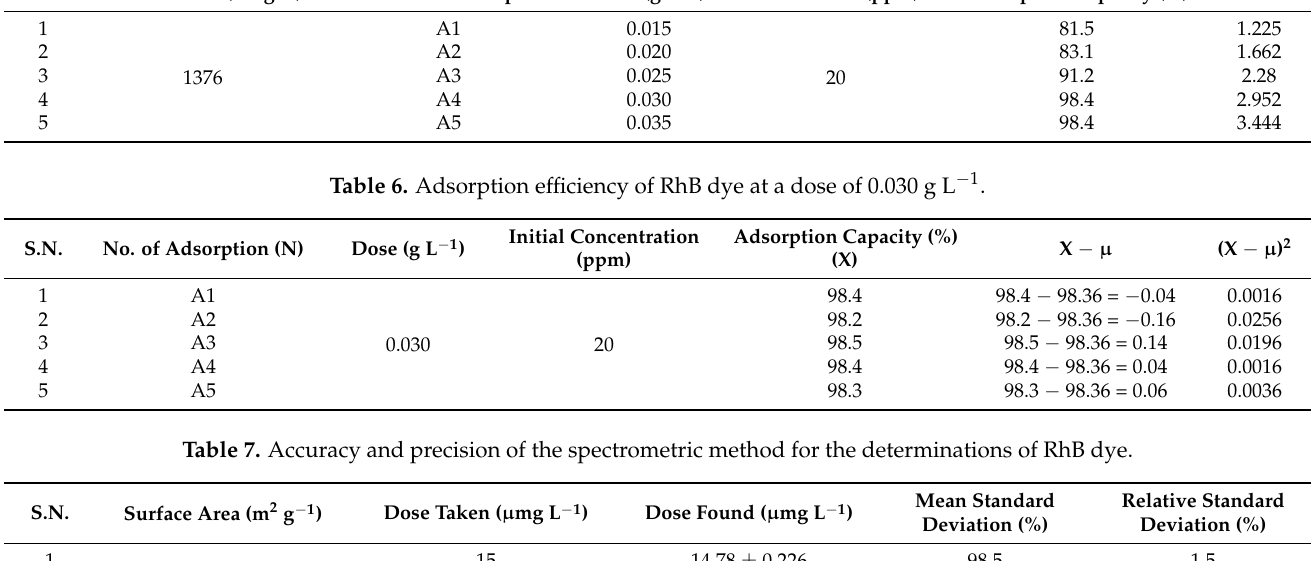
Figure 8. ( a ) RhB dye adsorption by AC (Db-s) at a dose of 0.02 g; ( b ) RhB dye adsorption by AC (Db-s) at a dose of 0.025 g; ( c ) RhB dye adsorption by AC (Db-s) at a dose of 0.03 g; ( d ) comparison of the % removals of RhB by AC (Db-s) and commercial carbon (at 0.030 g). Table 8. Percentage of RhB dye adsorbed by different doses of the as-prepared AC (Db-s). Table 5. Adsorption efficiency of RhB dye with the surface area, pH, and doses of the samples and adsorption capacity in 5 min. S.N.